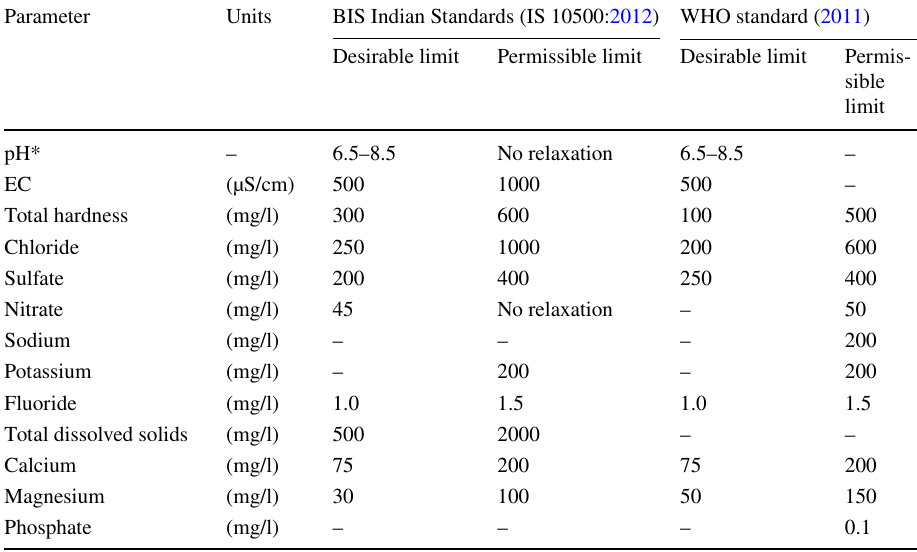
quality values of Bureau of Indian Standards (BIS) (IS 10500:2012) and WHO (2011) standards (Source: State